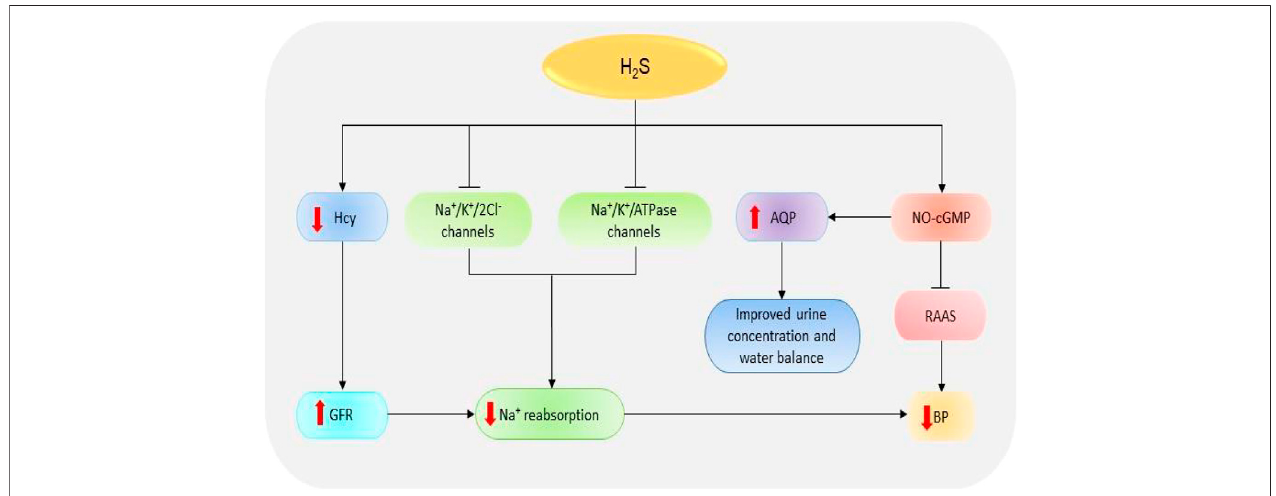
FIGURE 3 | The dramatic presentation of the kidney functions regulated by H 2 S. H 2 S stimulates NO-cGMP pathway resulting in an inhibition of RAAS and subsequent reduction in BP. The activation of NO-cGMP can also increase the expressions of AQP-2, thereby improving urine concentration and water balance. Besides, H 2 S induces the inhibition of Na + /K + /2Cl - and Na + /K + /atpase channels, thence reducing Na + reabsorption and consequently decreasing the BP. H 2 S also reducesHcylevelsresultinginanincreaseinGFR,suppressionofNa + ,and fi nallydeclineinBP.H 2 S,hydrogensul fi de;Hcy,homocysteine;Na + ,sodium;NO,nitric oxide; cGMP, cyclic guanosine monophosphate; GFR, glomerular fi ltrate rate; BP, blood pressure; AQP-2, aquaporin-2; RAAS, renin-angiotensin-aldosterone